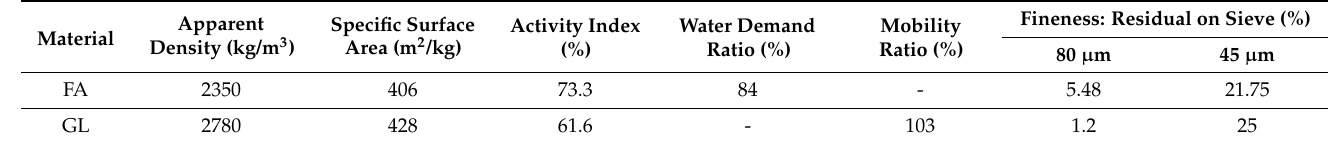
Table 2. Physical properties of fly ash and ground limestone.